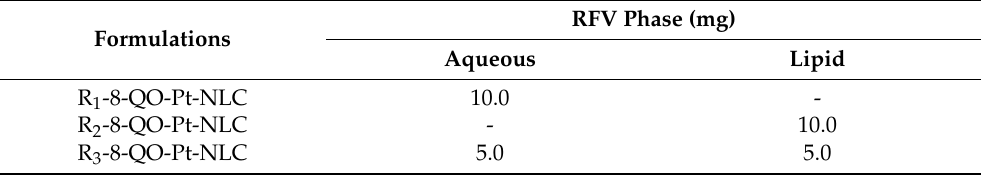
Table 1. The amount of RFV in the formulations.